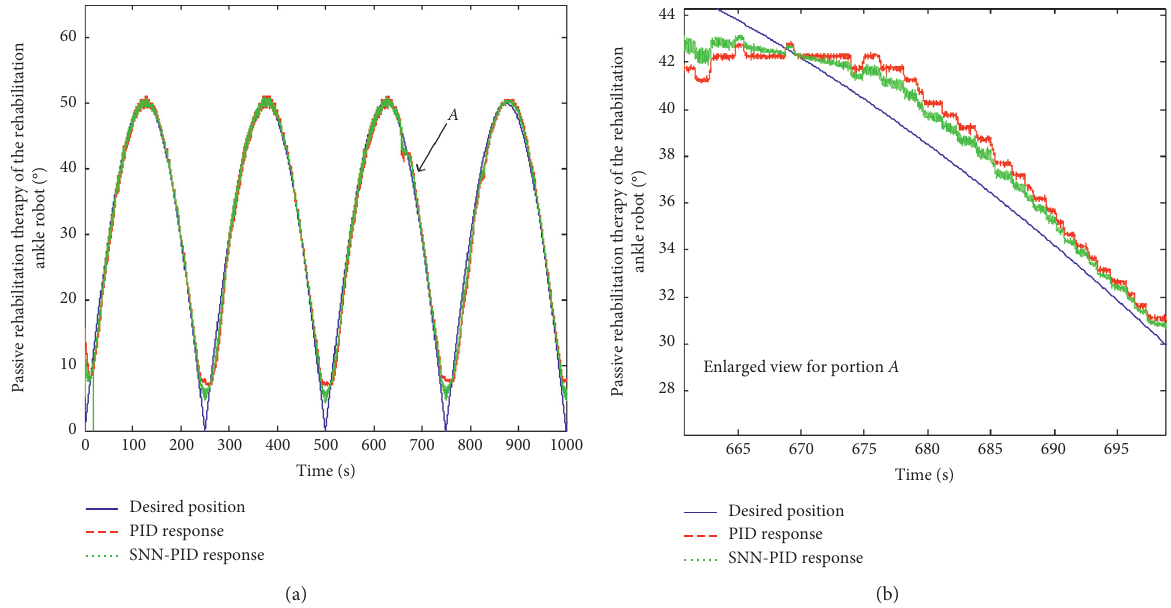
Figure 11: Passive rehabilitation therapy experiment under a half sinusoidal wave excitation of 0.004Hz with amplitude 50 ° : (a) tracking performance; (b) enlarged view for portion A in (a).